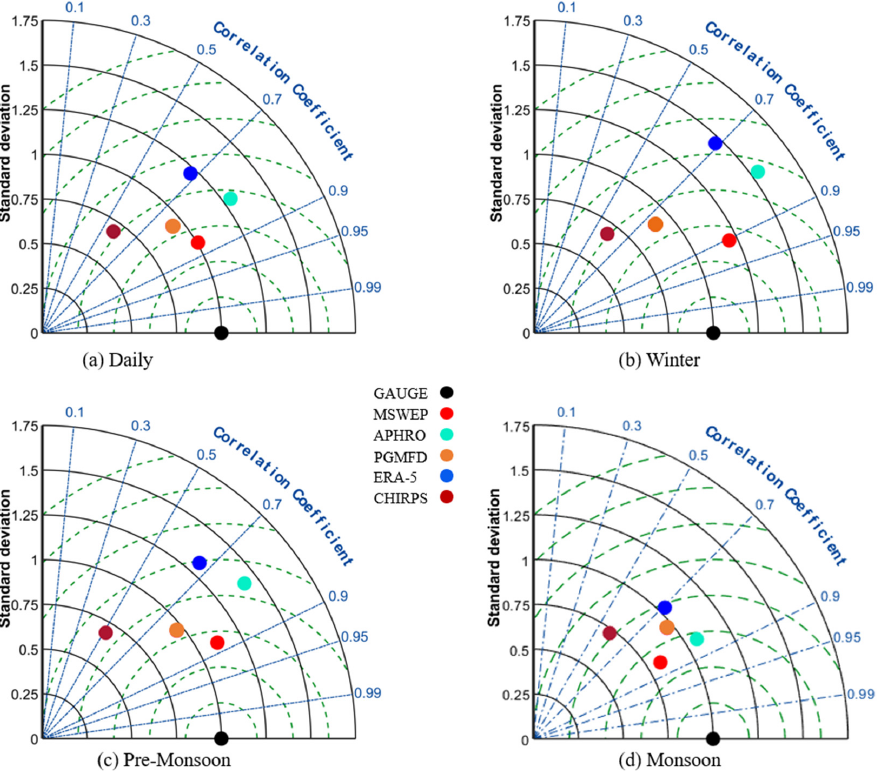
Figure 3. Taylor diagrams showing the statistical comparisons between GPPs and in-situ gauges data.